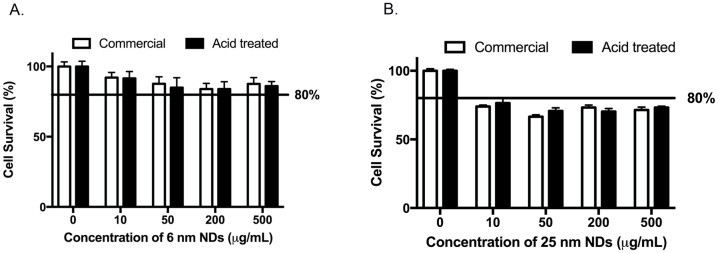
Cytotoxicity of 6 nm and 25 nm NDs in T24 cells.T24 cells were treated with 6 nm (A) or 25 nm (B) commercial (white bars) or acid-treated (black bars) NDs for 24 hours. Cytotoxic effects of NDs were evaluated by the MTT assay. Data are representative of at least three independent experiments and depicted as mean ± SEM. There were statistically significant (P < 0.05) decreases in the percentages of cell survival following treatment with NDs as compared to the corresponding 0 μg/mL sample as determined by 2-way ANOVA followed by Tukey’s multiple comparison’s test.